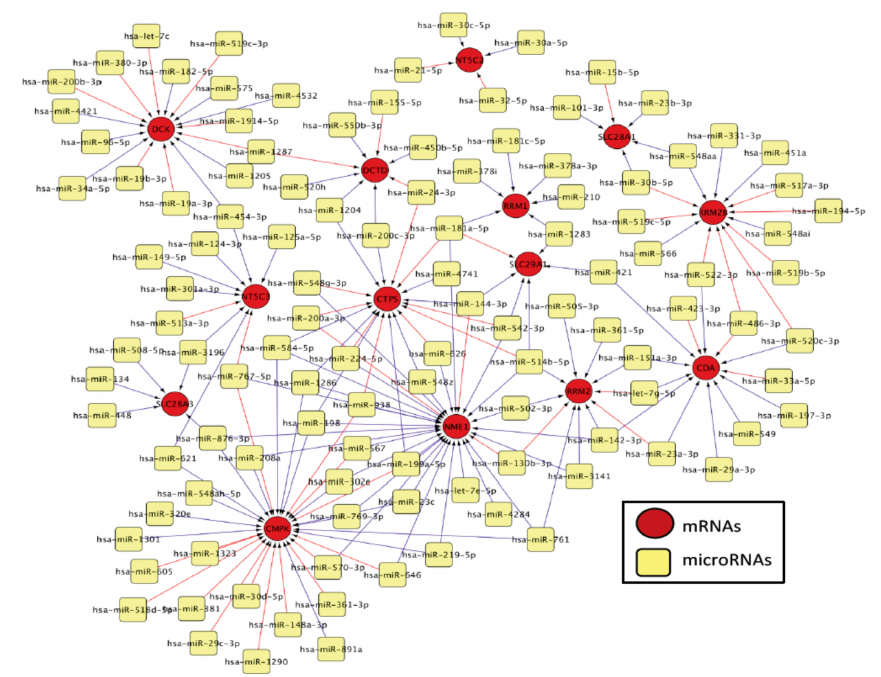
Figure 2. MicroRNA-mRNA network constructed using CyTargetLinker [12]. MiRNAs associated with the nucleoside analog metabolic pathway genes are shown in yellow and the mRNAs are depicted in red. Blue lines indicated positive and red indicated negative